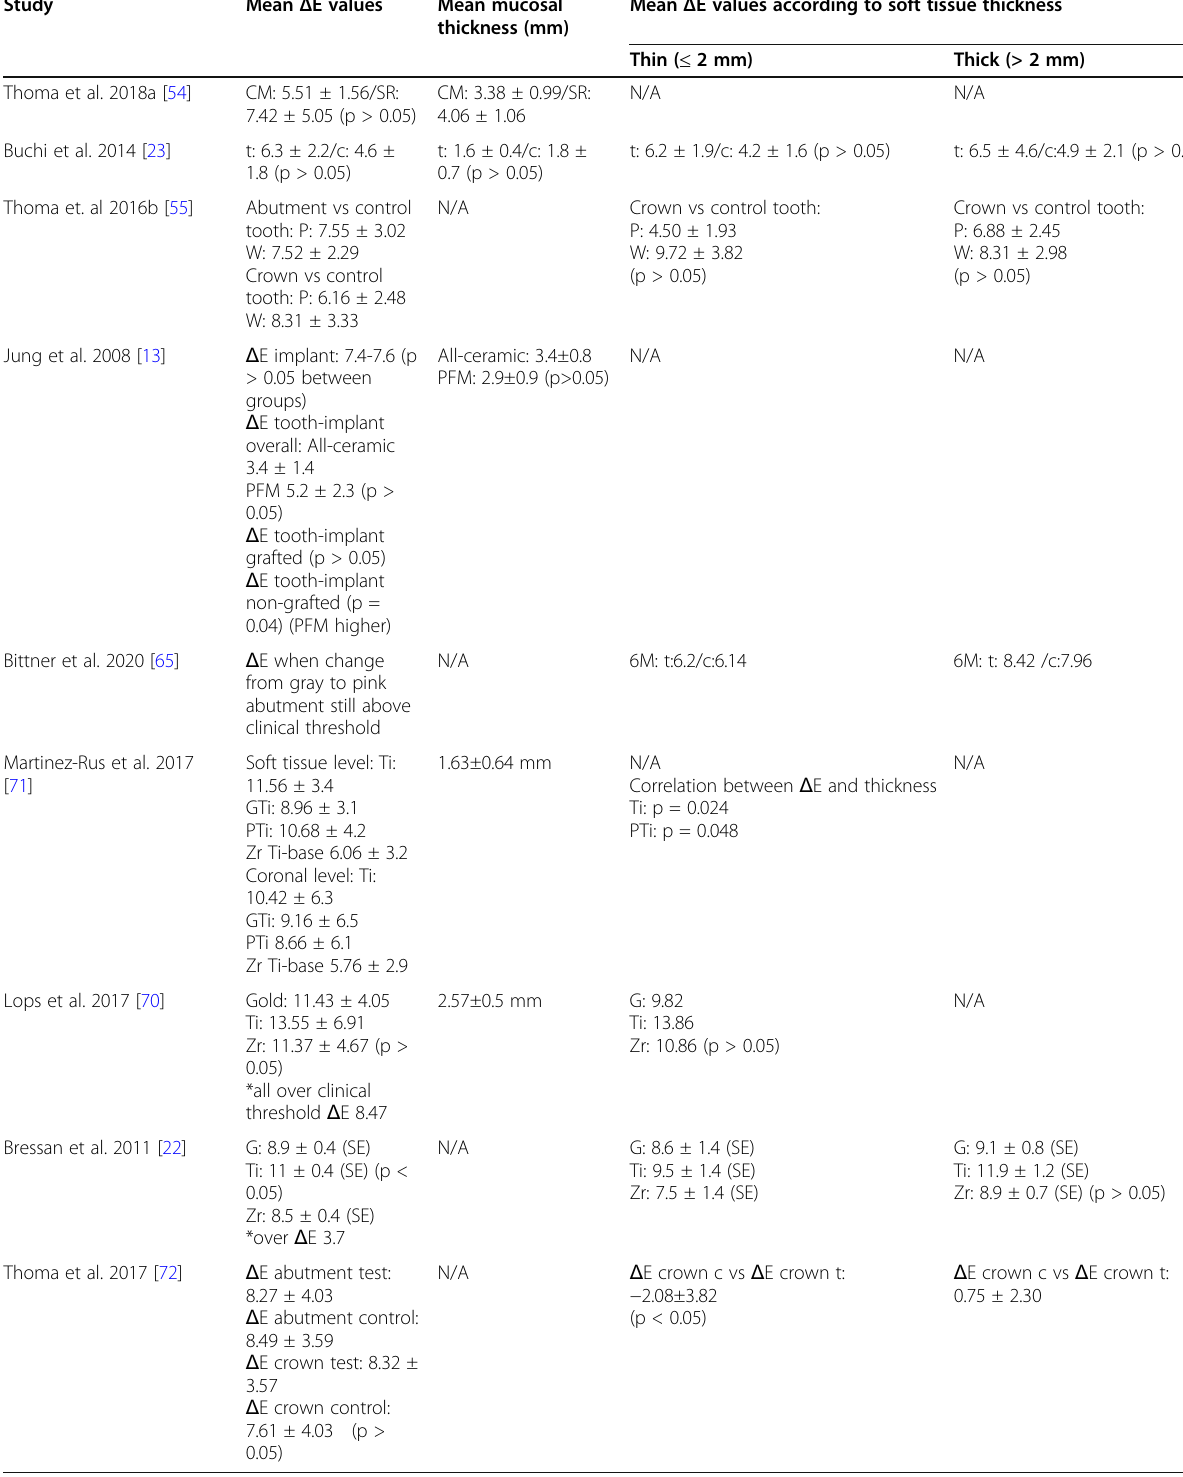
Table 6 Mean color difference ( ΔΕ ) data Study Mean ΔΕ values Mean mucosal